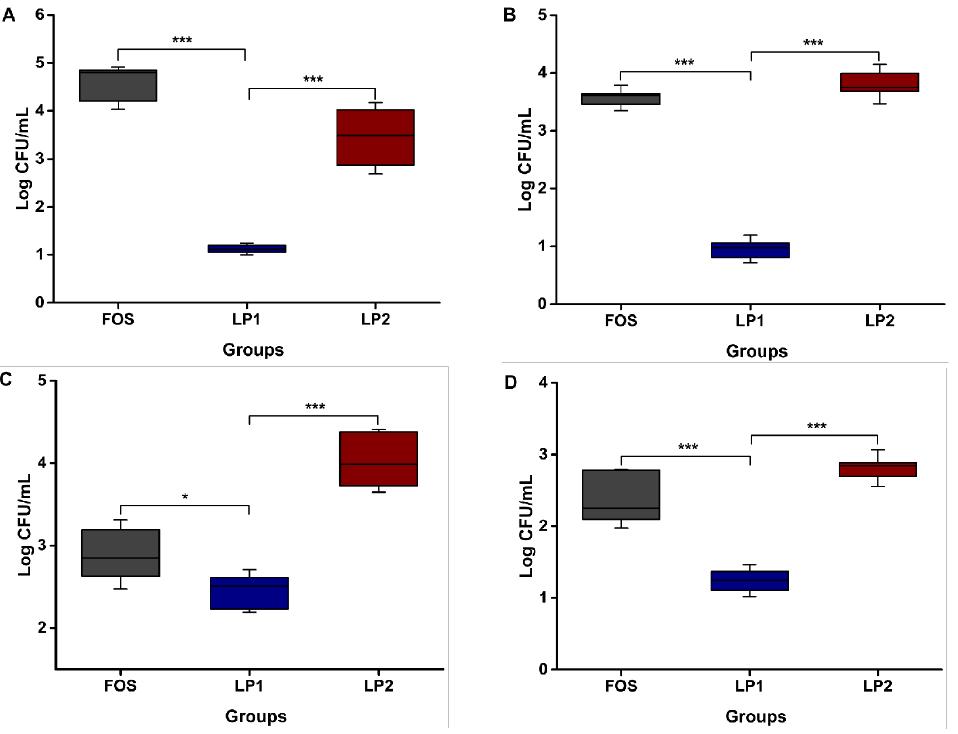
Figure 4. Stimulation effect of LP1 and LP2 on the population of Bifidobacterium adolescentis ( A ), Lactobacillus casei ( B ), Leuconostoc mesenteroides ( C ), and Lactobacillus plantarum ( D ) in a sugar free MRS base medium compared to FOS. * indicates a statistical difference of p < 0.05; ***, p < 0.001.